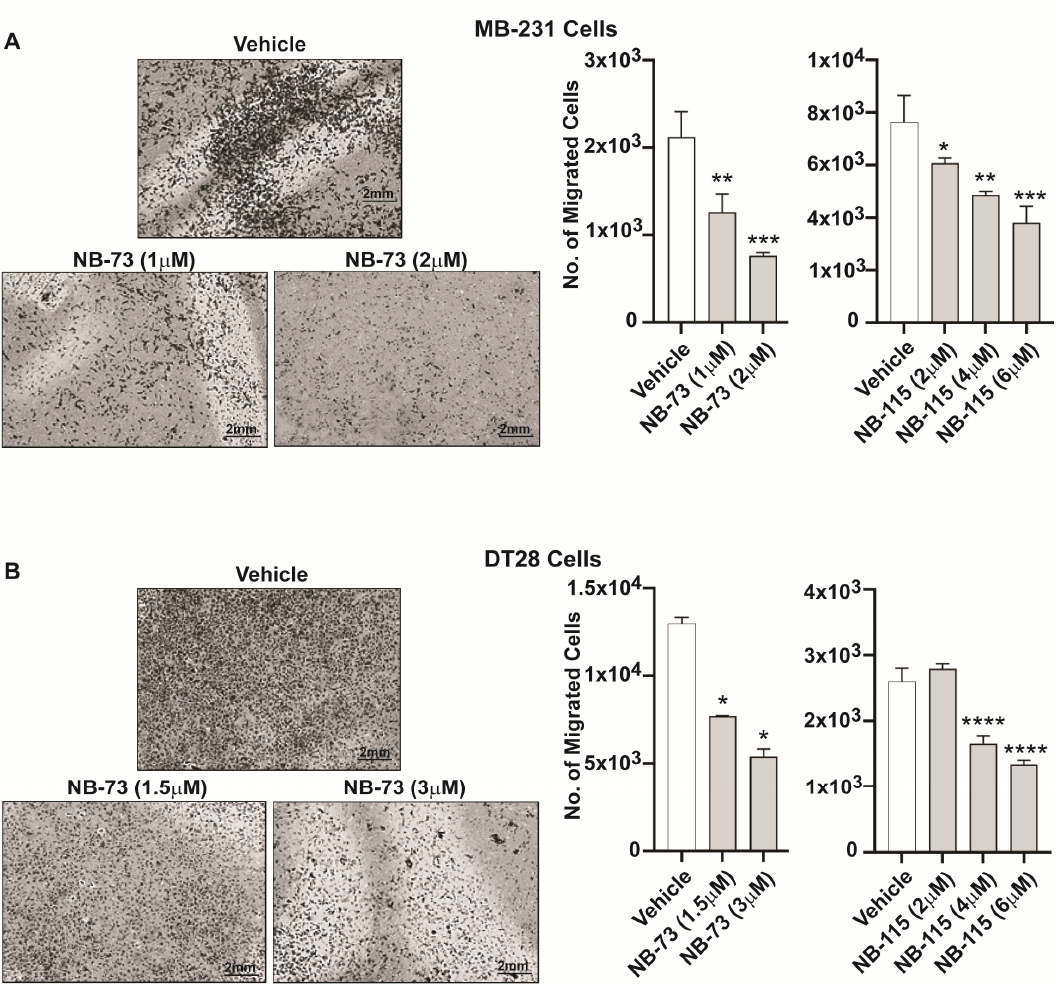
Figure 1. Dose-dependent effect of FOXM1 inhibitory compounds on migration of triple negative breast cancer (TNBC) cells, ( A ) MDA-MB-231 and ( B ) DT28 cells were treated with different concentrations of NB-73 and NB-115 for 48h, and the Boyden Chamber migration assay was conducted. At left, a few representative images of cell fields viewed microscopically are shown. Statistical analysis of data shown at right used one-way ANOVA and * p < 0.05, ** p < 0.01, *** p < 0.001 and **** p < 0.0001 are indicated; mean ± SD.